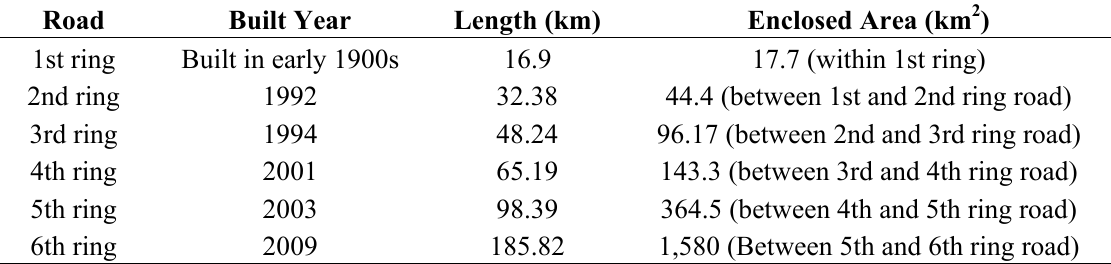
Table 1. Information of ring roads and urbanization in Beijing.